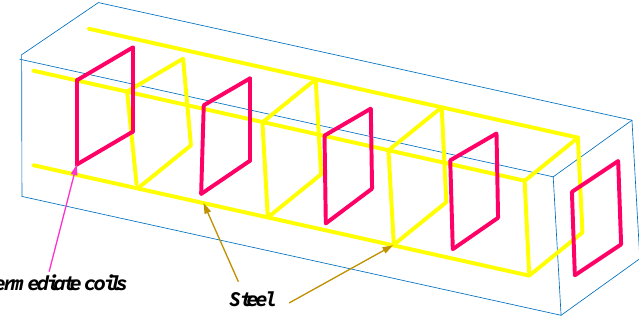
Figure 22. The overall structure of the inductively coupled WPT system.